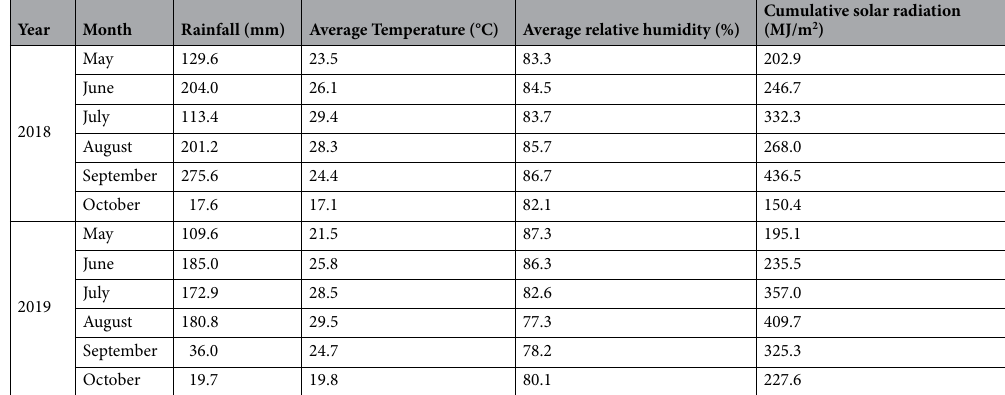
Table 7. Meteorological conditions during the rice growth seasons at the study site.